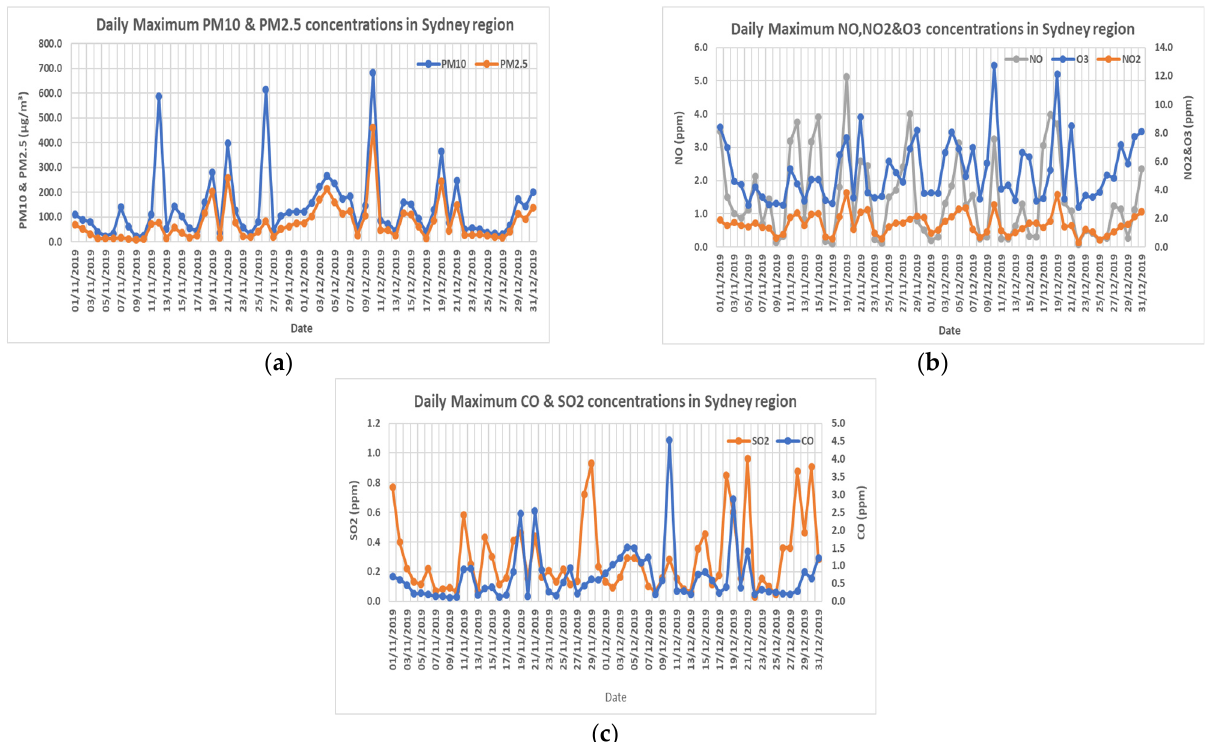
Figure 3. Daily maximum concentrations of ( a ) PM 10 , PM 2.5 , ( b ) NO, NO 2 , O 3 , and ( c ) CO and SO 2 measured at air quality monitoring stations in the Sydney region during November and December 2019. Table 1. Maximum hourly average pollutant loadings at selected sites in the Sydney region caused by the 2019–2020 Blue Mountains bushfires. UTC = Coordinated Universal Time; EST = Australian Eastern Standard Time.